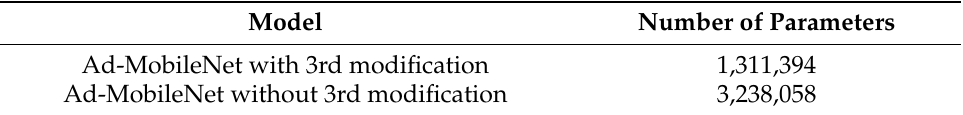
Table 2. Ad-MobileNet with and without the third modification.